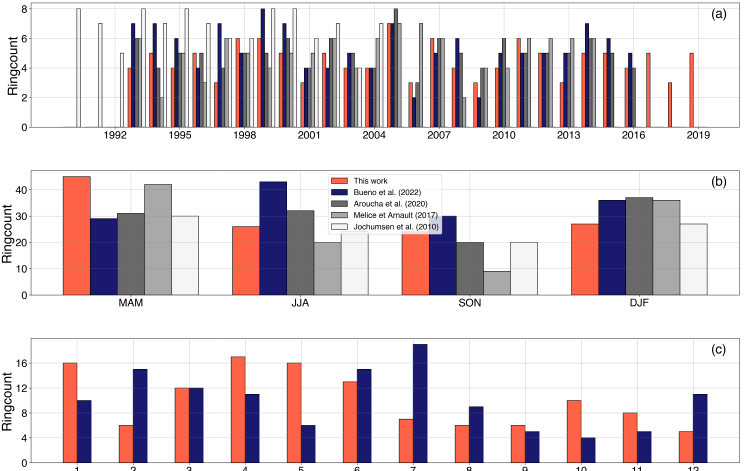
Figure 9. ( a ) Number of North Brazil Current (NBC) rings generated per year. ( b ) Seasonal cycle in the generation of NBC rings. ( c ) Ring generation as a function of months. Comparison with other